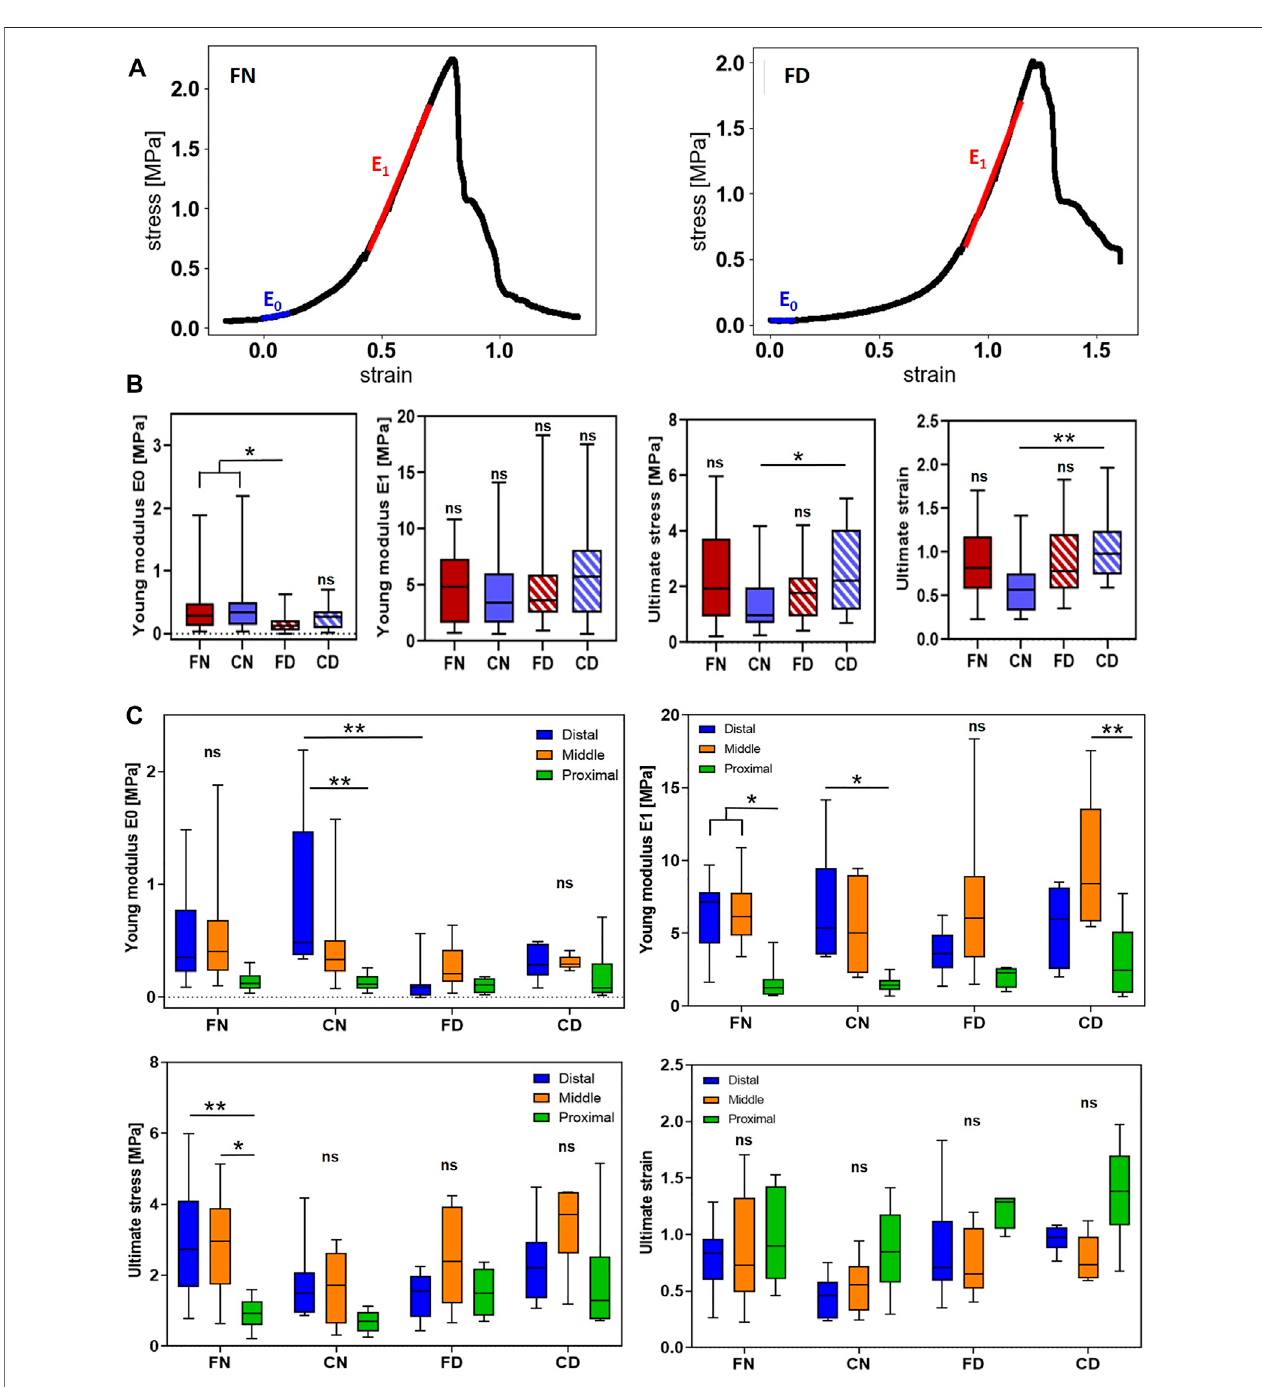
FIGURE 7 | Mechanical testing: (A) Typical stress – strain curves for the distal region of a native carotid (left) and a decellularized scaffold (right) in both curves. Young ’ s modulus of elastic phase (E0) and the viscoelastic phase E1 and the rupture point (the highest value of stress reached) were easily identi fi ed. Boxplots of the mechanical test parameters are shown in (B) and (C) , where (B) represents parameters for the four main groups together, while (C) shows more detailed data of individualsegmentswithinthegroups.FN,freshnativeartery;CN,cryopreservednativeartery;FD,freshlydecellularizedscaffold;CD,cryopreserveddecellularized scaffold; level of signi fi cance is displayed as (*) for p < 0.05 and (**) for p < 0.01.